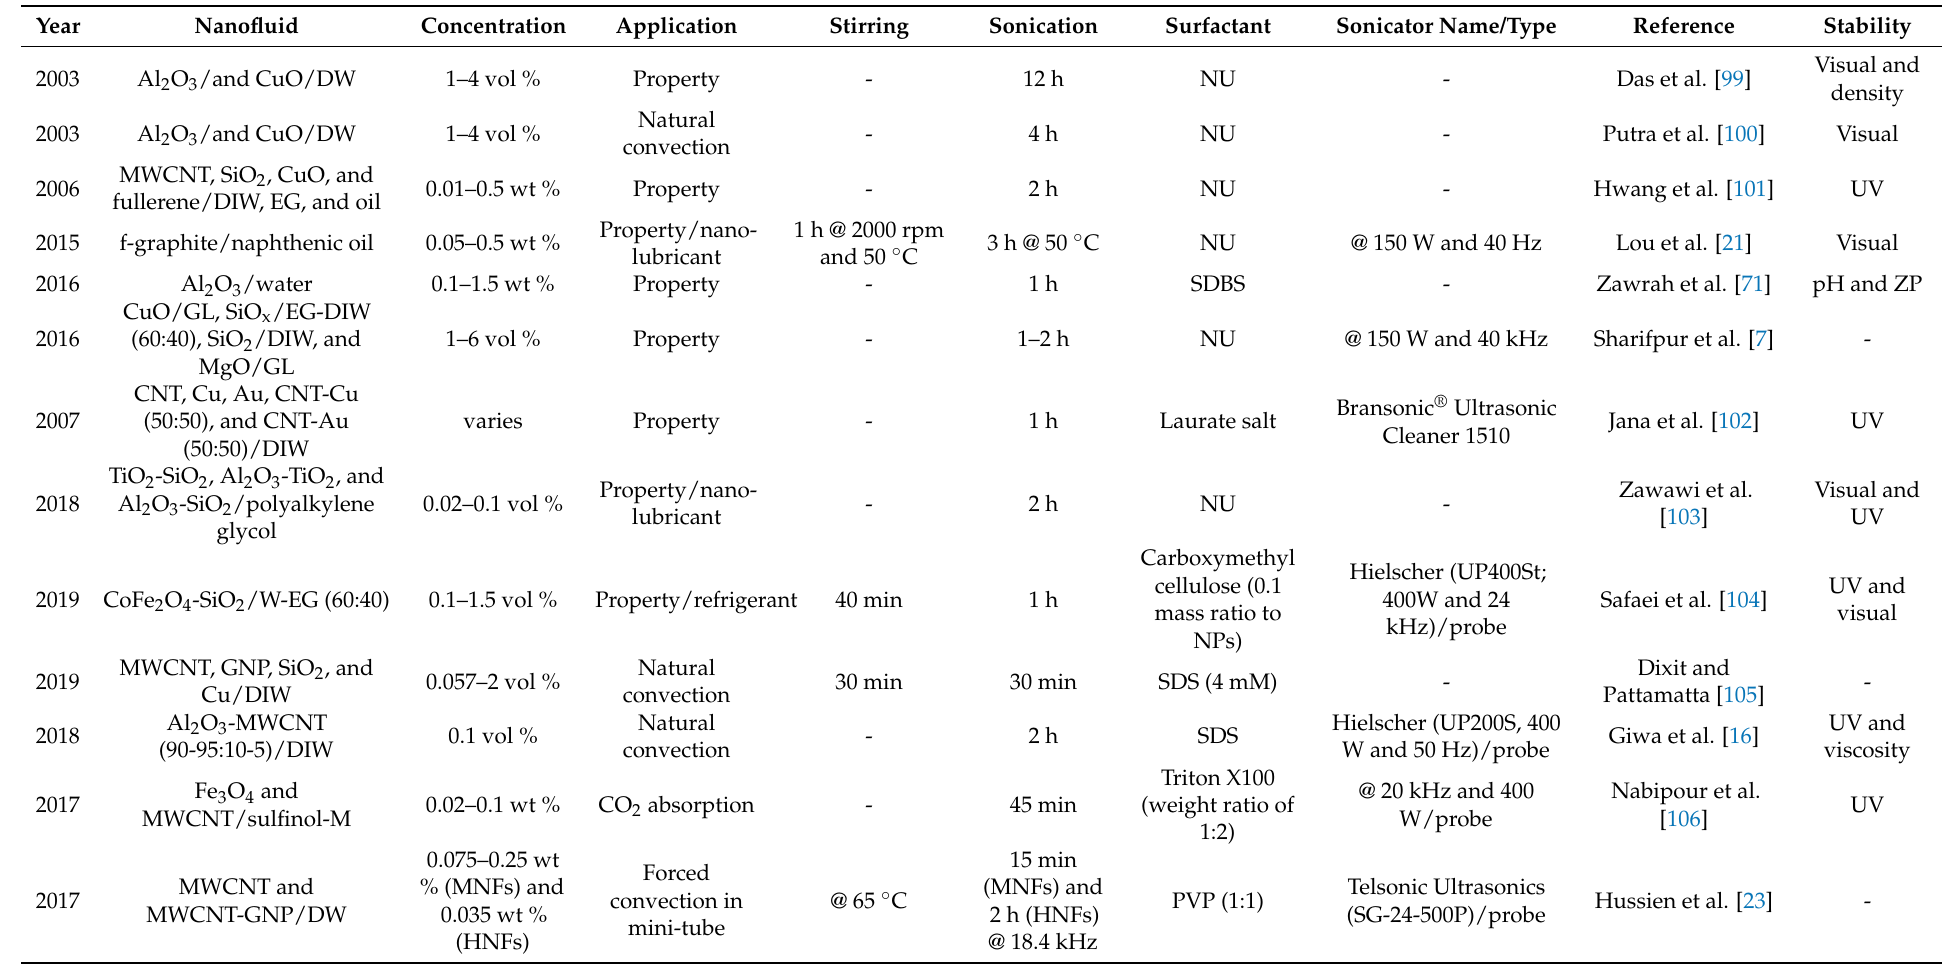
Table 1. Current scenario in nanofluid